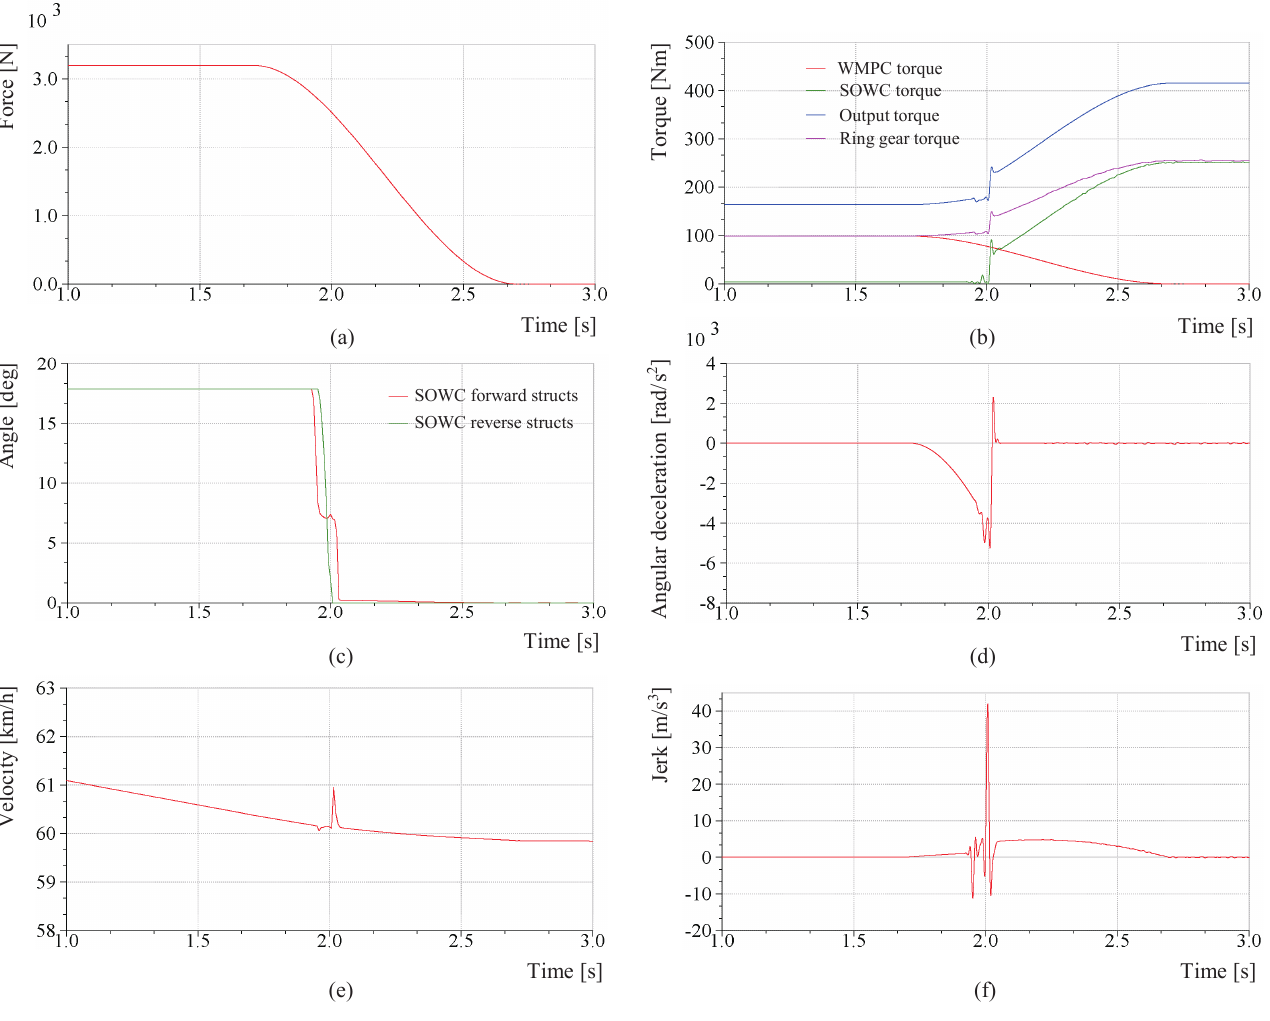
Figure 13. Simulation results of the downshifting process: ( a ) Changes of WMPC pressing force. ( b ) Changes in torque transmitted by each component. ( c ) Changes of struts rotation angle. ( d ) Changes of ring gear angular deceleration. ( e ) Changes in vehicle speed. ( f ) Changes in